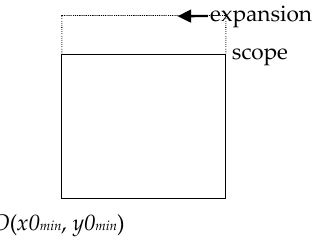
Figure 6. Tile map vertical expansion.